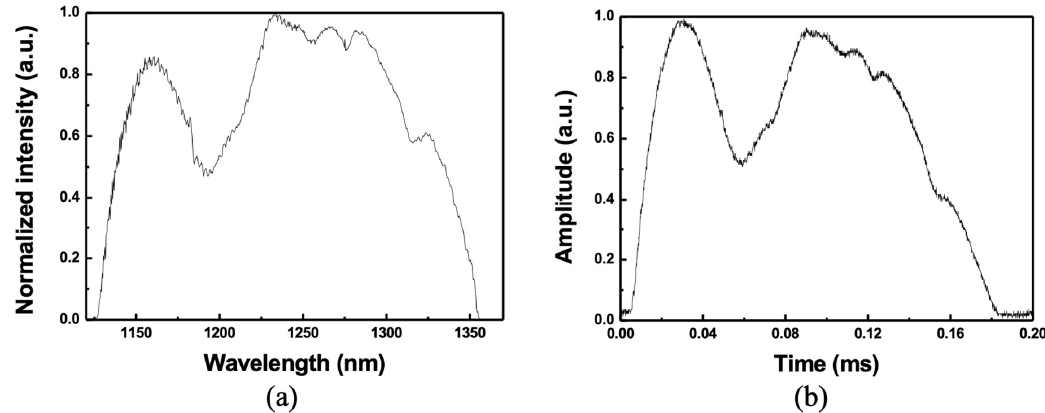
Figure 3. ( a ) Optical spectrum (linear scale), and ( b ) temporal output of wideband WSL. For broadband WSLs, the net gain is very important, as it relates to optical alignment.